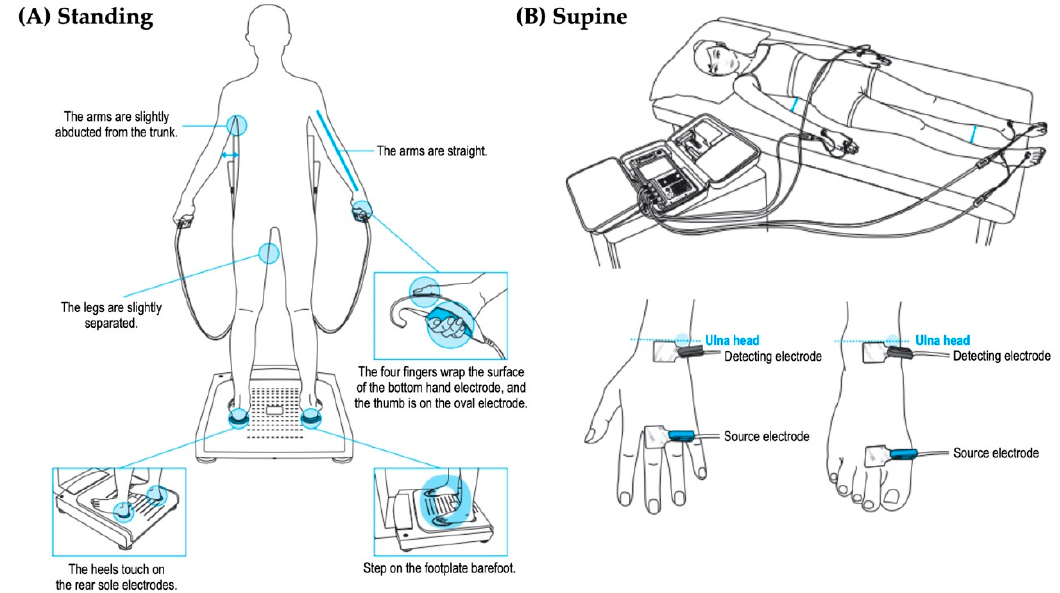
Figure 1. The testing postures and the electrode placements ( A ) BIA in the standing position ( B ) BIA in the supine position [permitted from the manufacture]